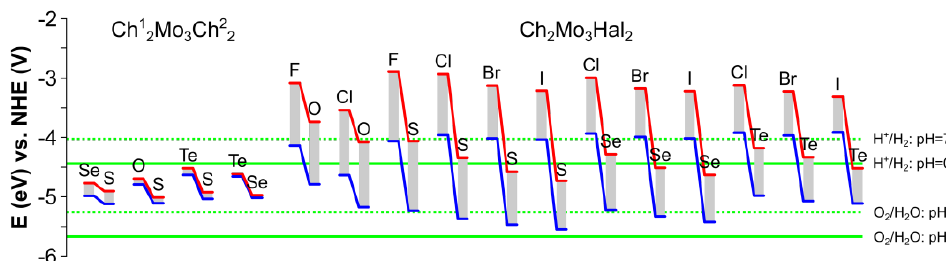
Figure 6. Band edge positions of dynamically stable Janus Ch 1 2 Mo 3 Ch 2 2 and Ch 2 Mo 3 Hal 2 Chevrel monolayer (Ch 1 /Ch 2 = O, S, Se, Te; Hal = F, Cl, Br, I) structures compared with the redox potentials of water. The values are given concerning the vacuum level (in eV). The CBM and VBM are marked by red and blue lines. The redox potentials of water are denoted as the green lines for pH = 7 (dashed) and pH = 0 (solid) [74].